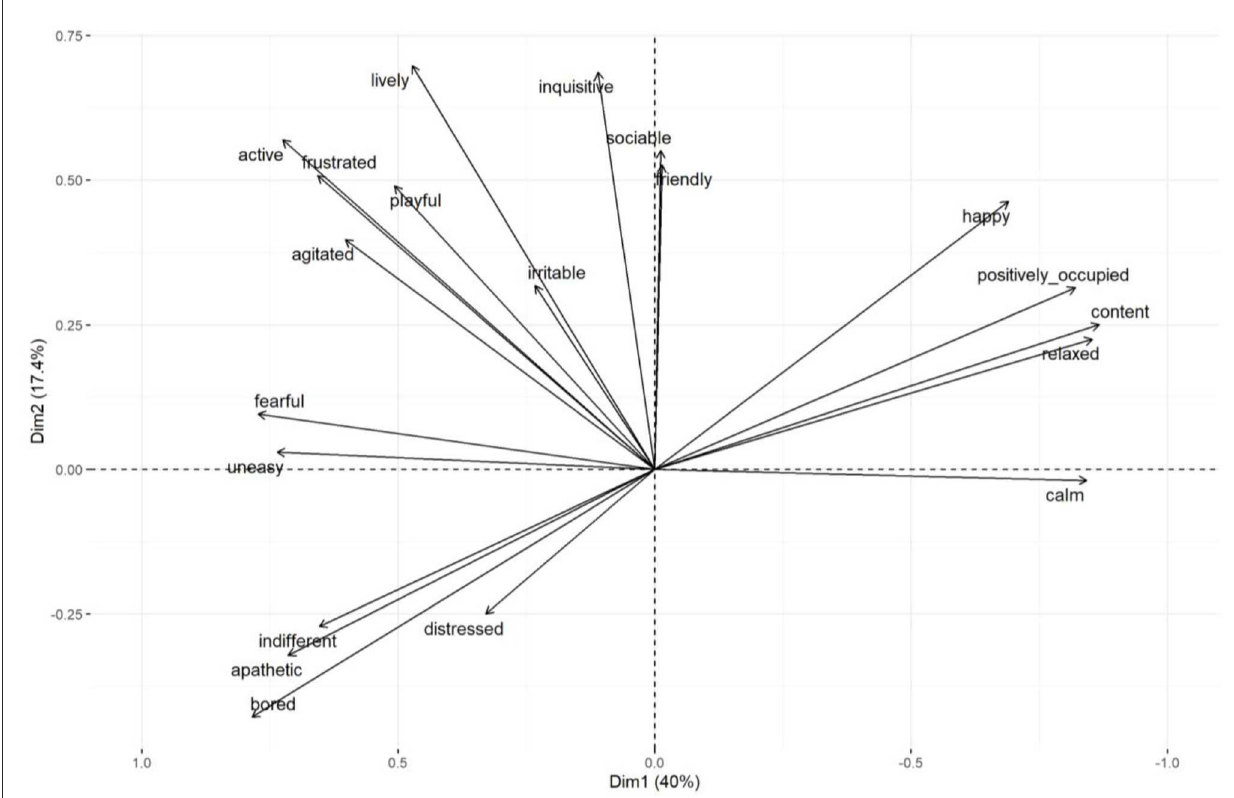
FIGURE6 Group 2: Variable correlation plot displaying the relationship between all variables in PC1 (Dim1) and PC2 (Dim2) and each terms value figure in contribution to the principal component.